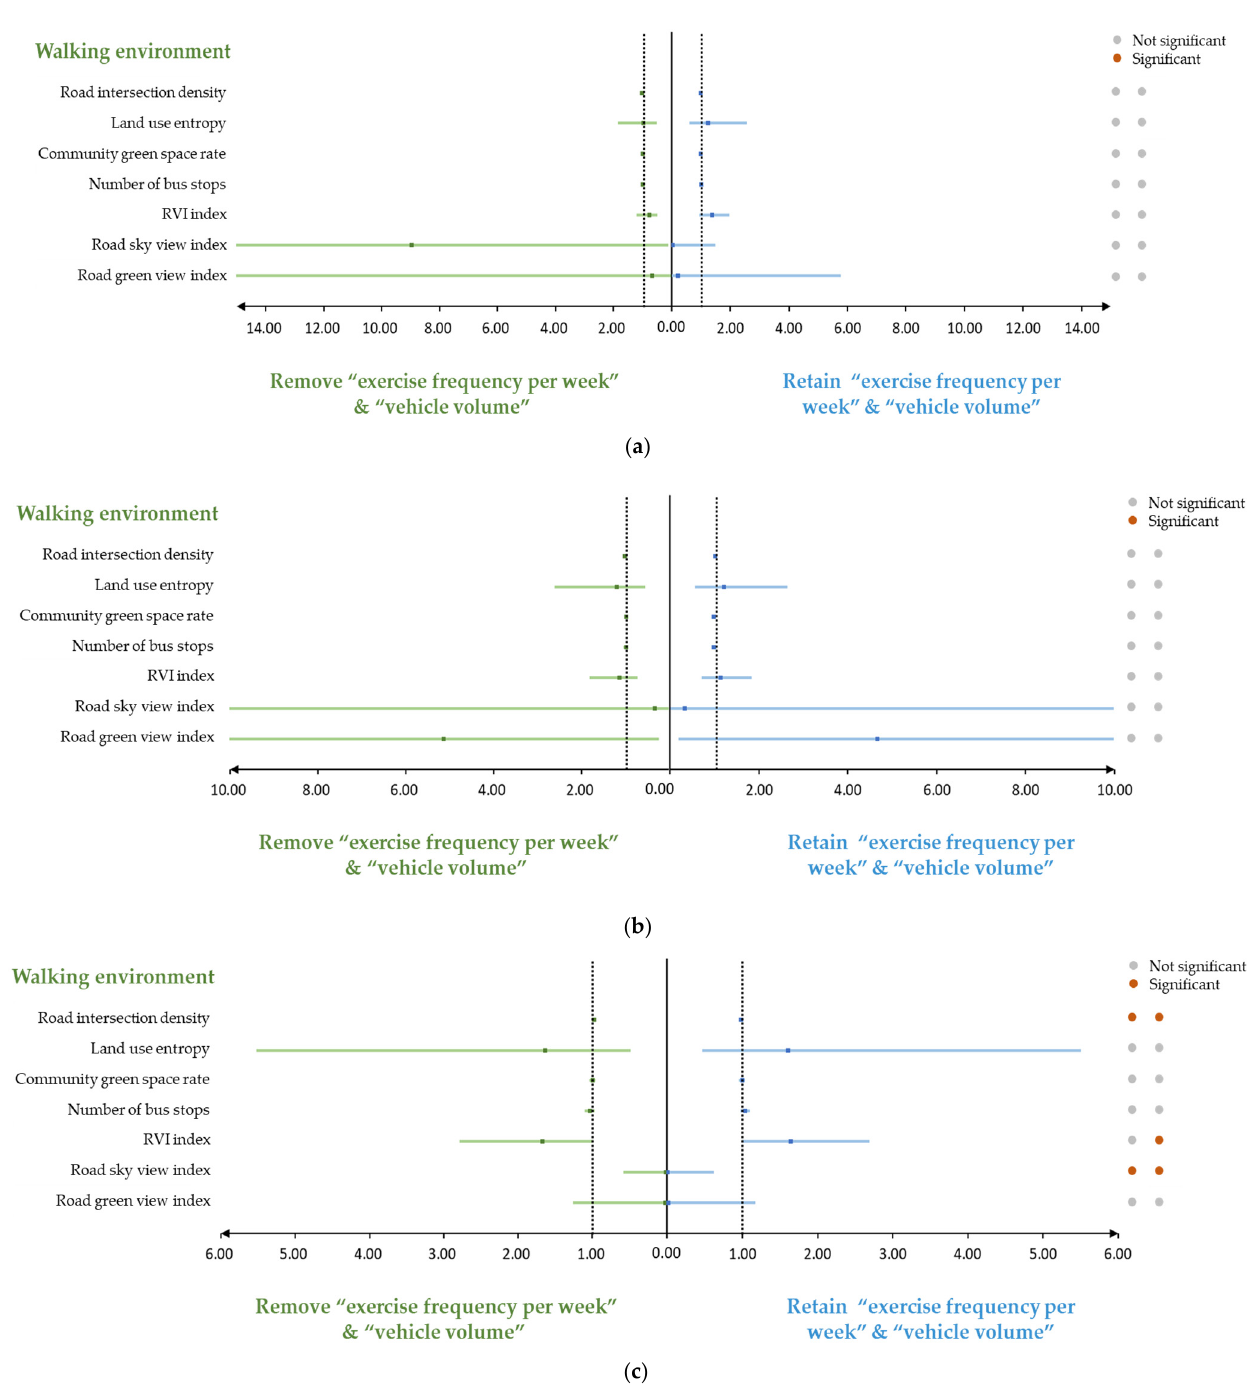
Figure 5. Sensitivity analysis. ( a ) Sensitivity analysis of the total sample; ( b ) Sensitivity analysis of the male sample; ( c ) Sensitivity analysis of the female sample. the male sample; ( c ) Sensitivity analysis of the female